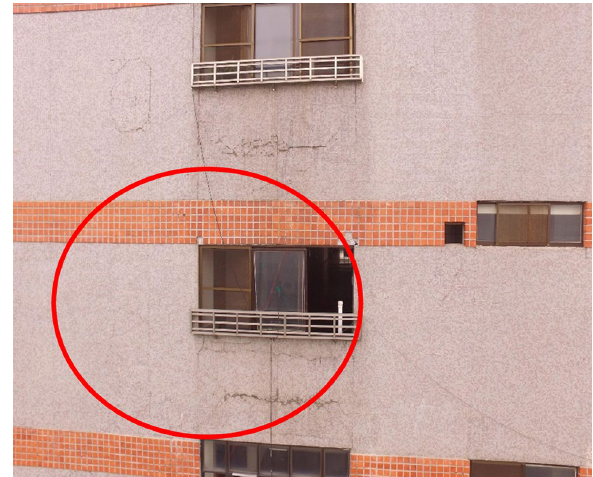
Figure 9. The sample image by UAV